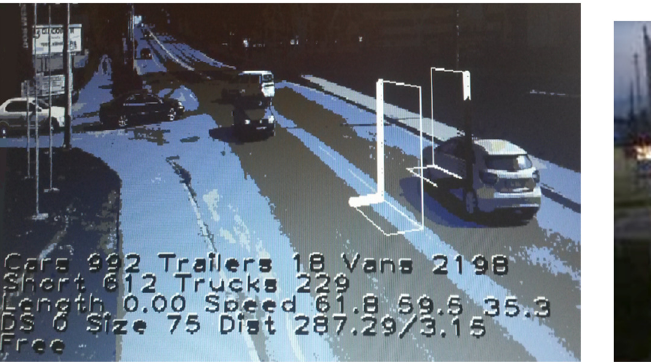
Figure 2: Virtual passing gateways [ 11 ] . Figure 3: Catching the